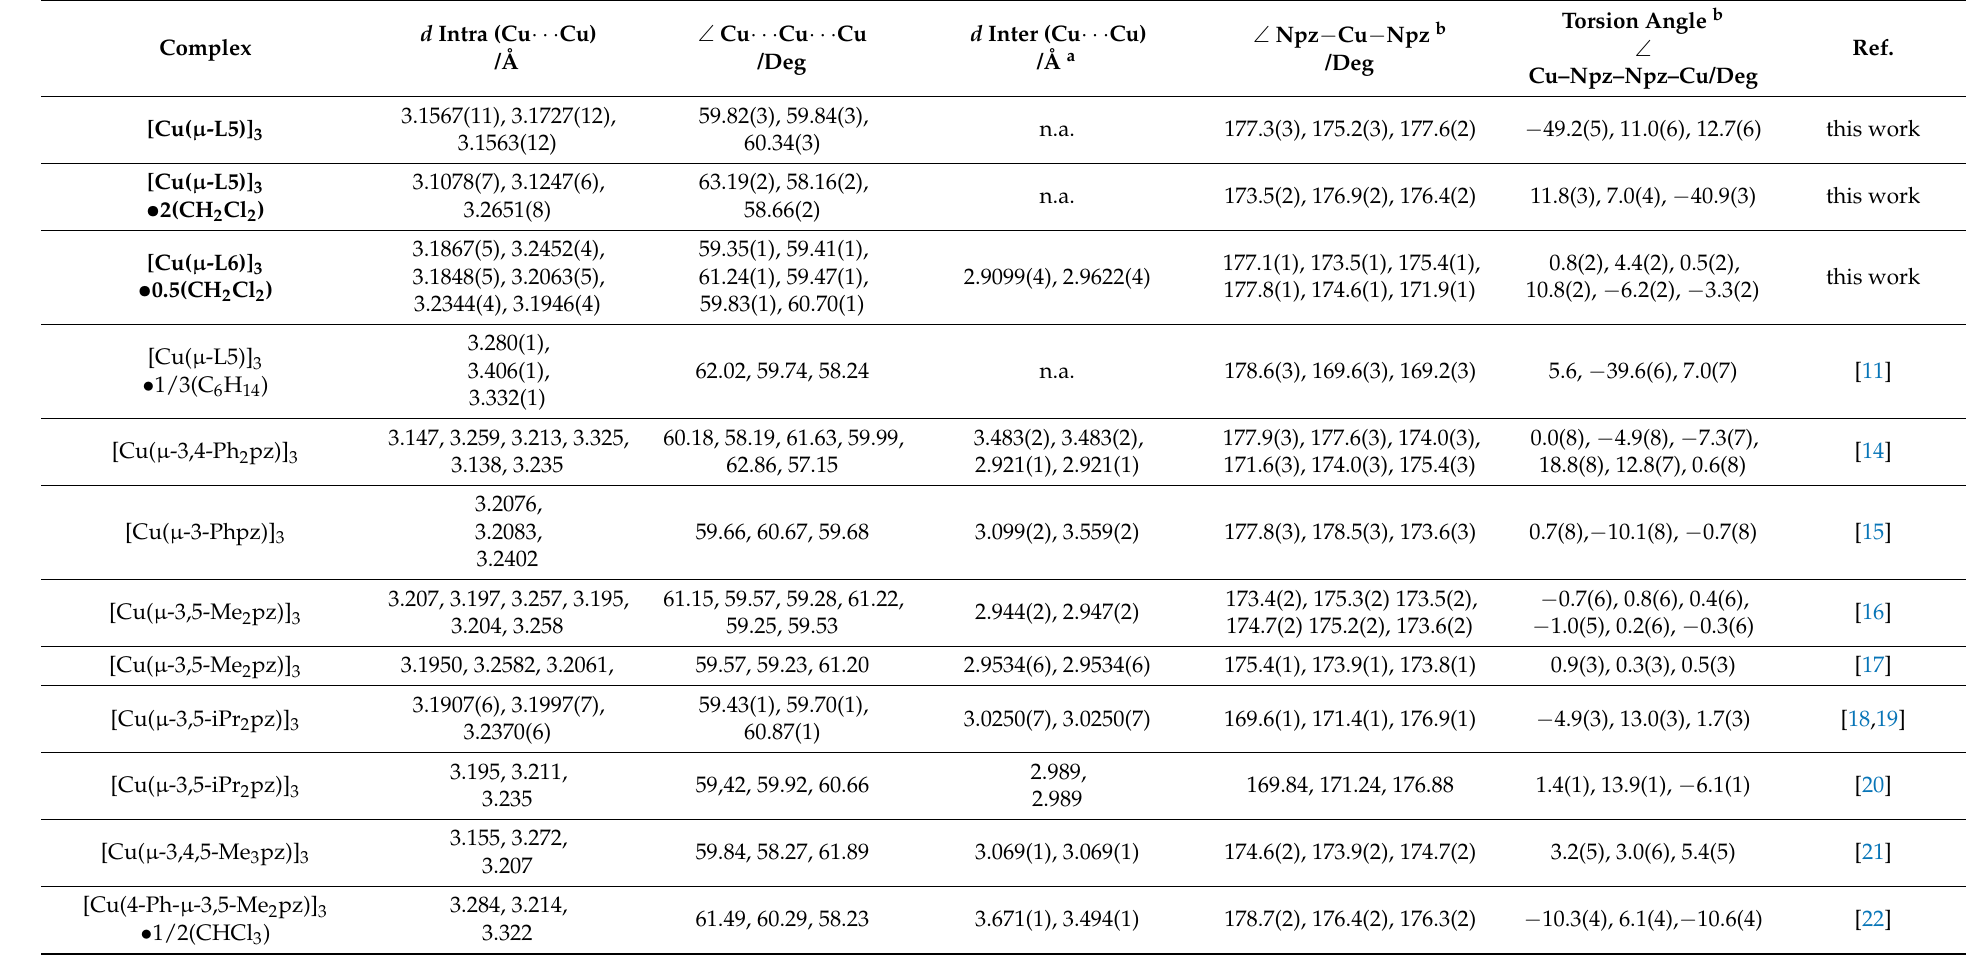
Table 1. Structural parameters of selected cyclic trinuclear pyrazolato copper(I)